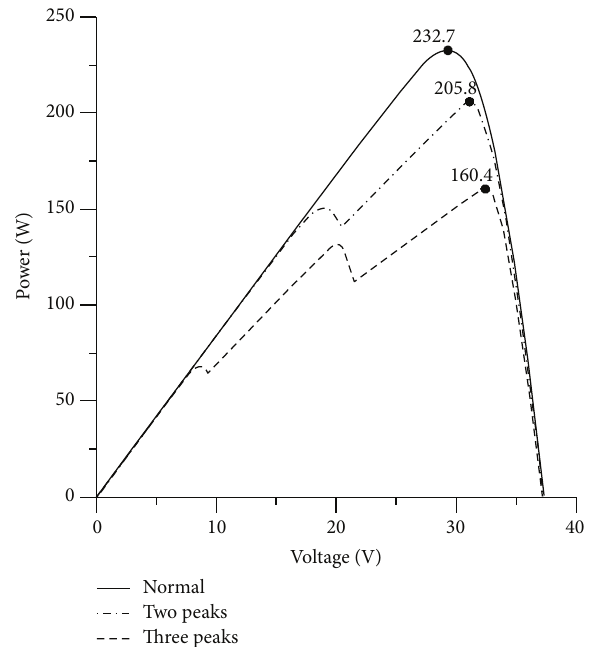
Figure 10: Power voltage characteristic curve for PV panel under various partial shading conditions.